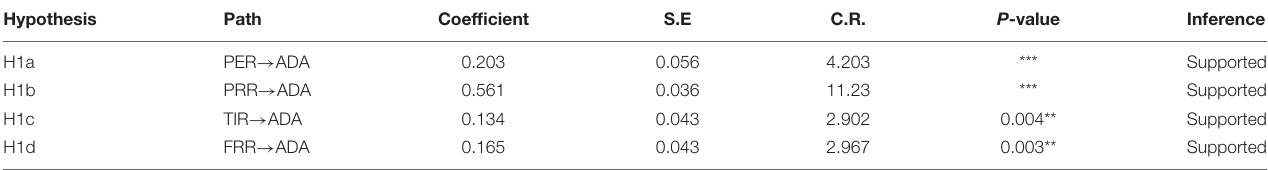
TABLE 6 | Hypothesis testing ( n = 436).